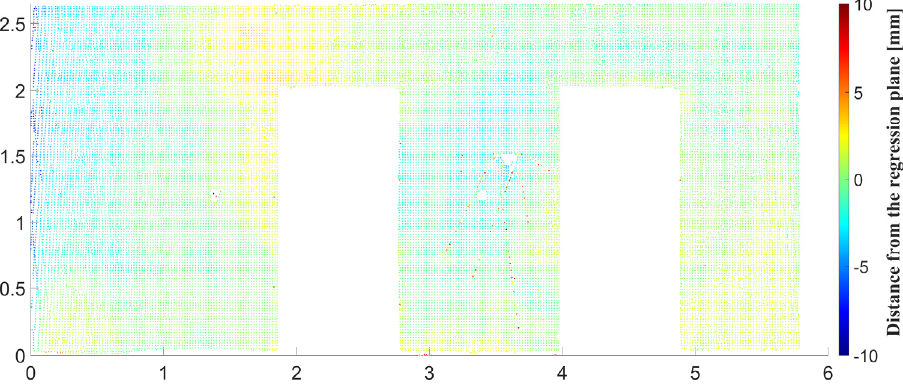
Figure 19. Deviation map, the wall no. 7—quantification of flatness of the wall.